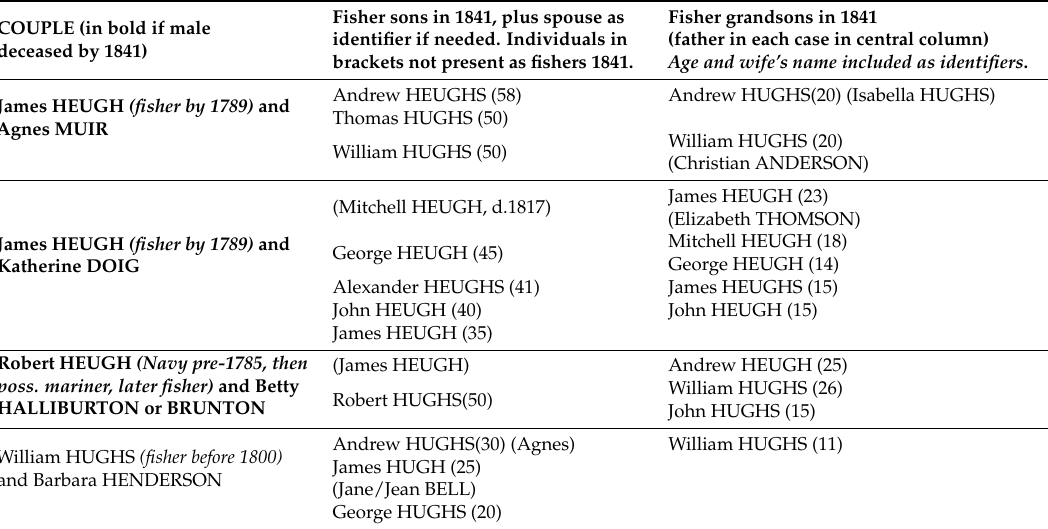
Table 6. Ancestral couples for Pittenweem fishers in